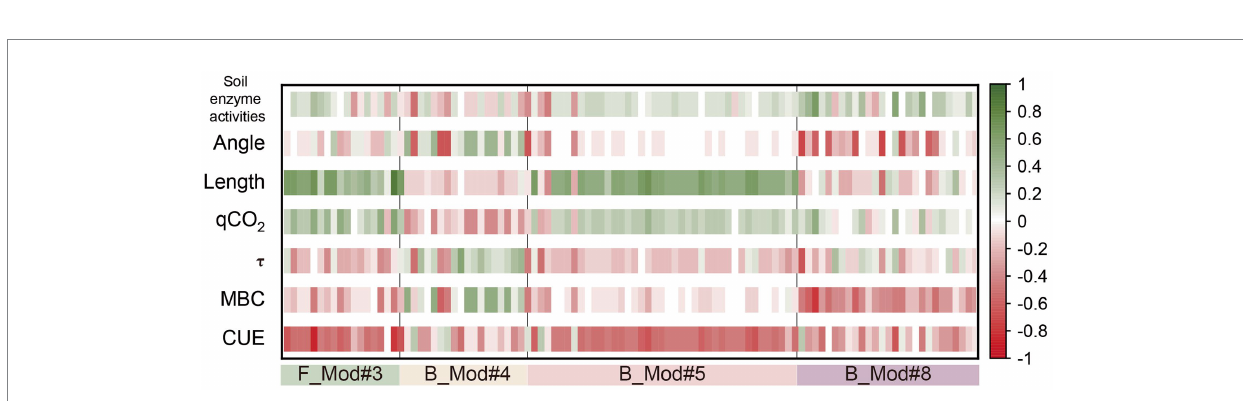
FIGURE 5 Relationships of the keystone genera with metabolic efficiency, microbial physiological traits and soil enzyme activities. F_Mod#3, key fungal assemblies in module#3; B_Mod#4, B_Mod#5, and B_Mod#8 were key bacterial assemblies in module#4, module#5, and module#8. Length, the relative C: nutrient-acquiring